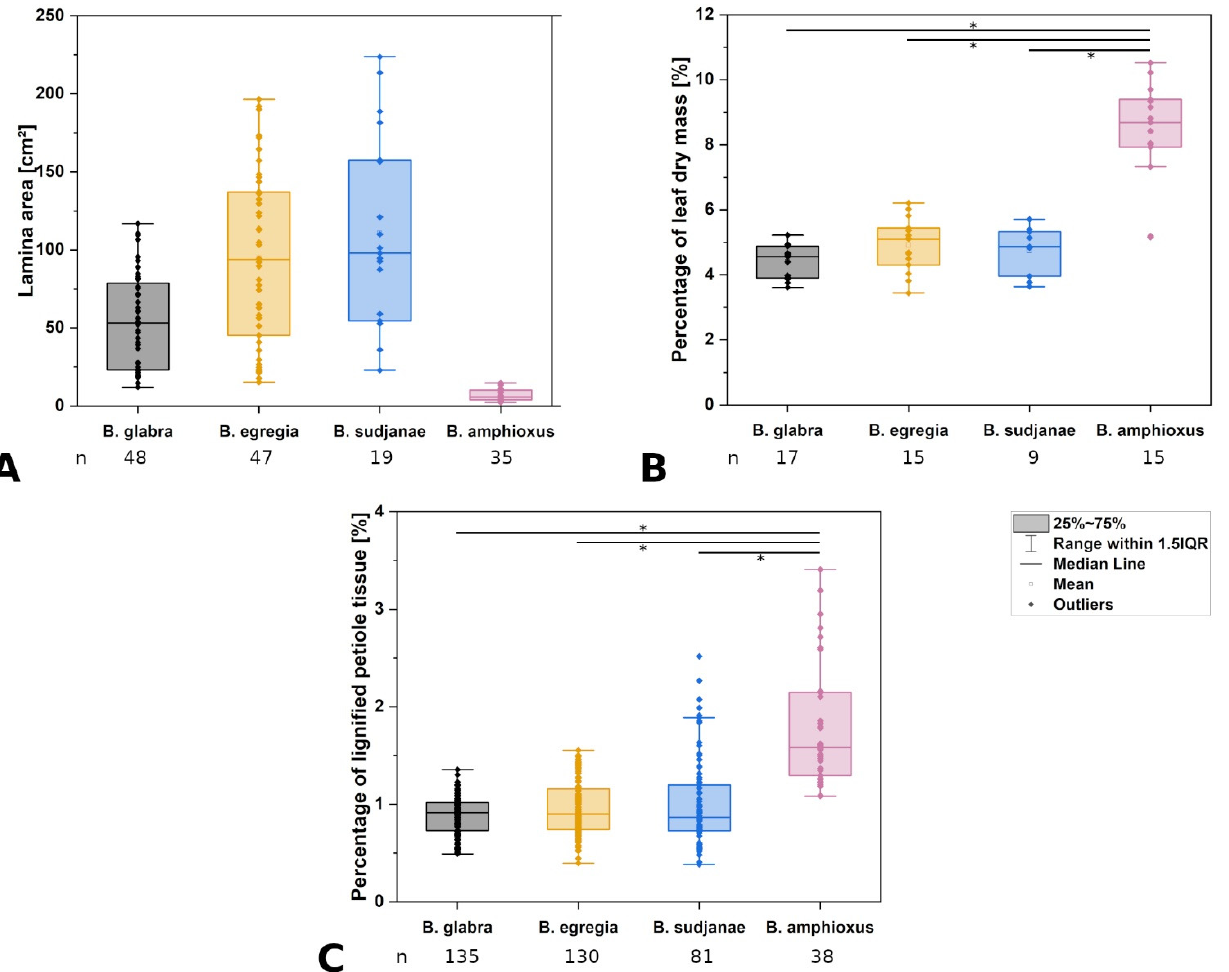
Figure 3. Comparison of leaf characters in different Begonia species. Lamina area in cm 2 ( A ), percentage of leaf dry mass ( B ) and percentage of lignified tissue in the petiole ( C ) of Begonia glabra , B. egregia , B. sudjanae, and B. amphioxus . Percentage of dry mass refers to the percentage of the ratio between dry mass in mg to fresh mass in mg. Percentage of lignified petiole tissue refers to ratio of lignified tissue to non-lignified tissue in %. The box represents data between first and third quartile. Whiskers include data points within 1.5× of the interquartile range. The median is marked with a line, the mean with a square. Asterisks (*) mark significant differences between species analyzed via Kruskal–Wallis ANOVA. For each species, the sample size (n) is shown below the species name. p - values are shown in Table 2. All samples were taken from one plant per species (two for B. sudjanae ). Table 1. Median values of measured leaf variables of the different Begonia species. Interquartile range and sample size (n) are given in brackets. Leaf variables refer to measurements taken from the whole leaf (including petiole and lamina). Petiole and lamina variables show measurements of only petiole or lamina, respectively. All samples were taken from one plant per species (two for B. sudjanae ).